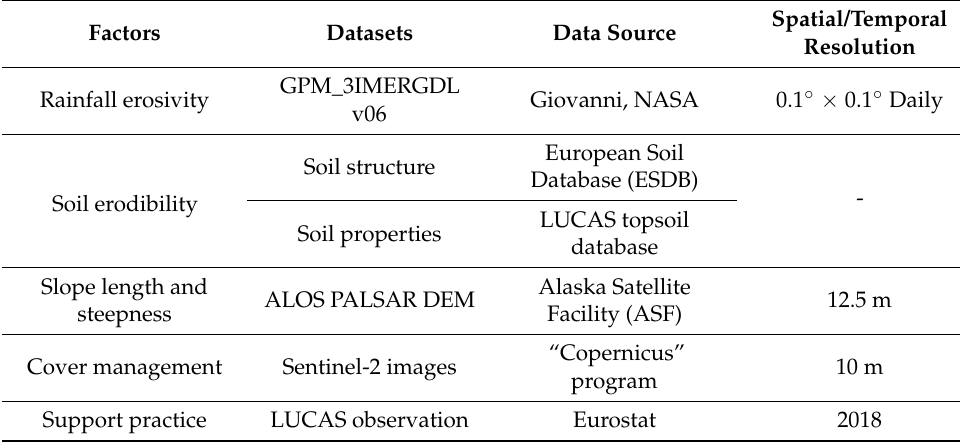
Table 1. Input datasets used in the Revised Universal Soil Loss Equation